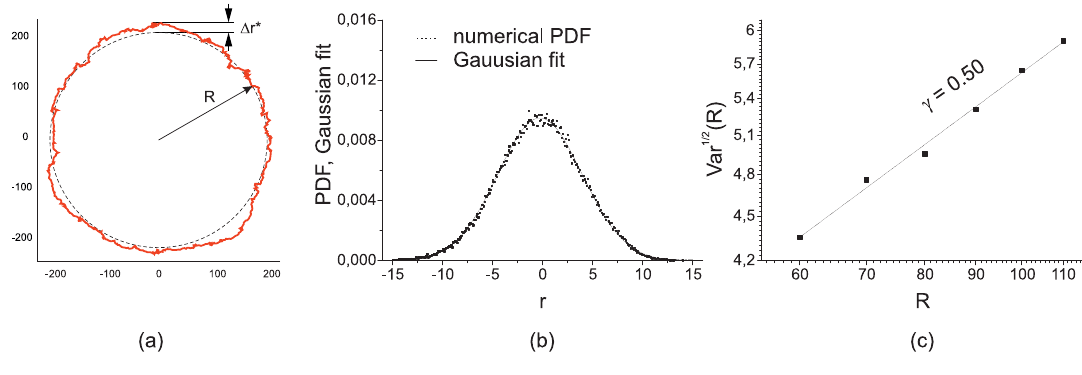
Figure 7 . (a) Distribution of the fluctuations of the inflated ring without the boundary; (b) Gaussian scaling of fluctuations as a function of the path length in log-log